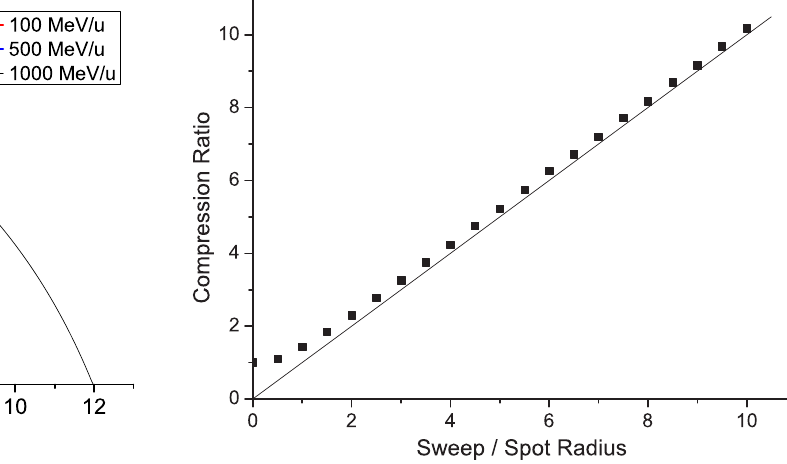
FIG. 3. Side view of the Cu wedge that produces a 20% velocity gradient for 238 U beams with the specified energies. The 3D wedge is uniform in the direction into and out of the paper. The height is arbitrary, as it will be designed to match the sweep of the beam.